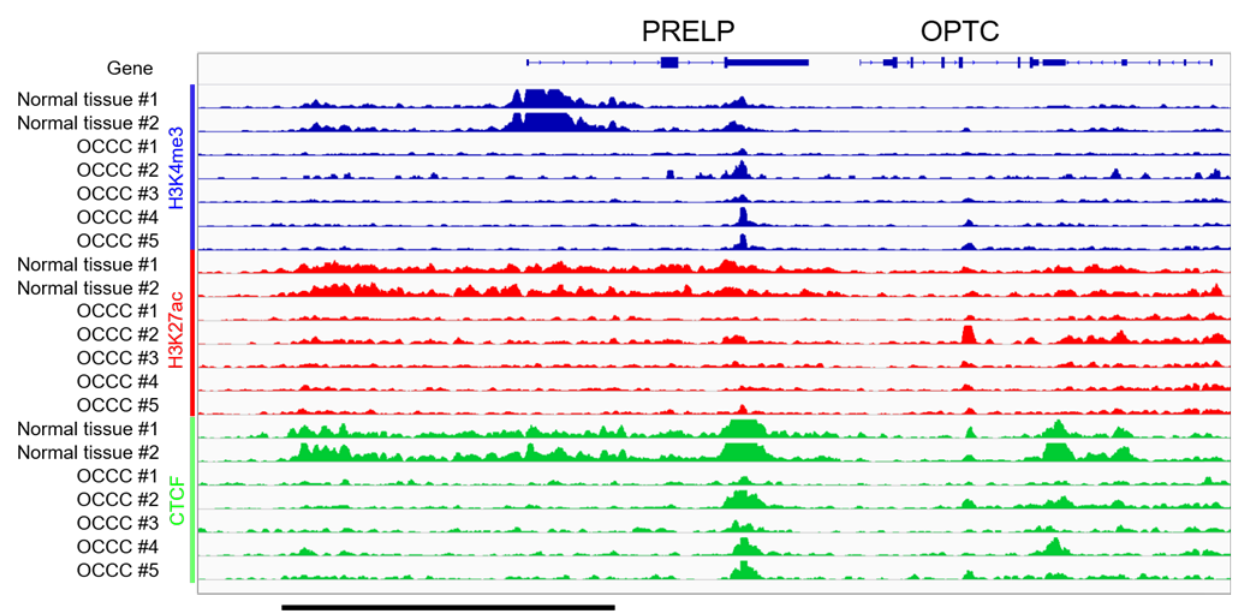
Figure 4. Loss of epigenetic marks at the PRELP locus in clinical tissues of ovarian clear cell carcinomas (OCCC). The integrative genomics viewer (IGV) tracks of H3K4me3 (blue), H3K27ac (red), and CTCF (green) peak at the PRELP locus, illustrating the loss of epigenetic marks around the PRELP gene promoter upstream region in OCCC ( n = 5). Normal ovarian tissues ( n = 2) on the opposite healthy ovary were used as a comparison. All data ranges are standardized as 0 – 2. The upstream region of the PRELP gene promoter is indicated by a black underline at the bottom of the figure.